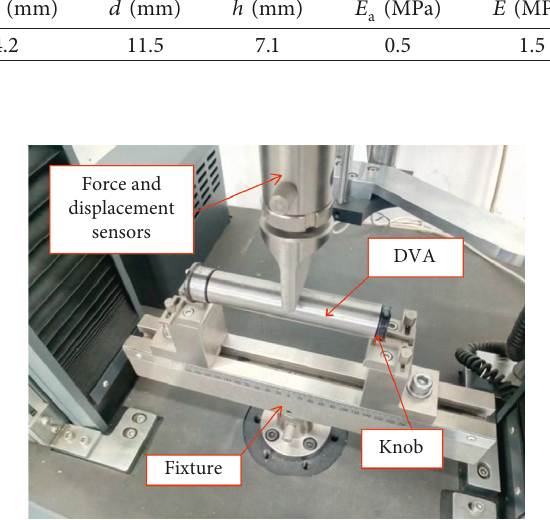
Figure 14: Experiment of the radial stiffness of the DVA.